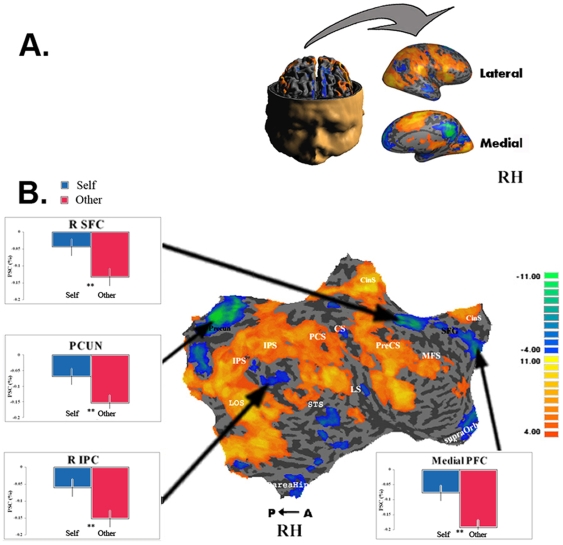
Intrinsic ROIs and Self Recognition – Right Hemisphere.A. Folded and inflated views of RH. B. Conjunction map of all tasks vs. fixation contrast. Multi-subject analysis (N = 11) testing whether at least one contrast activated the region in at least u subjects with FDR <0.05. The intensity represents the minimum number of subjects for whom the region was activated, ranging from at least 4 subjects (orange) to 11 subjects (yellow). Graphs show multi-subject average BOLD activations of ROIs for responded self and responded other conditions. Intrinsic ROIs showed higher levels of activation in the responded self than in the responded other condition. Error bars represent SEM. ** p<0.01.